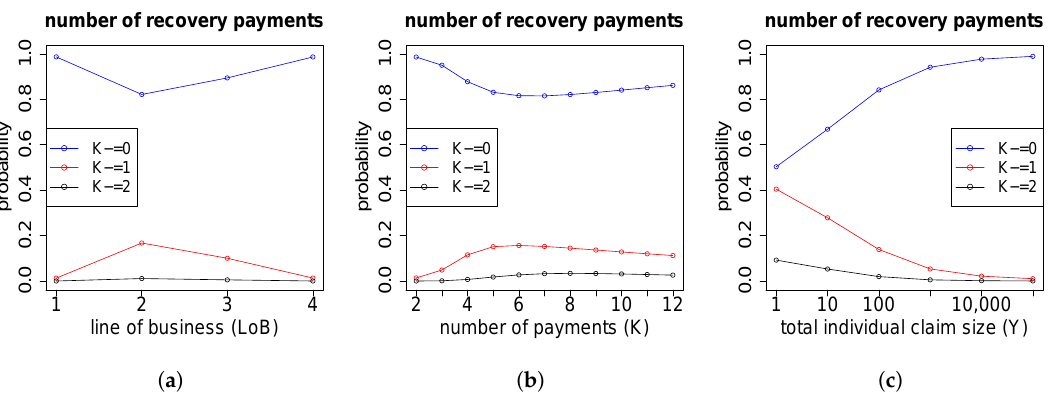
Figure A10. Number of recovery payments K − w.r.t. the features ( a ) LoB ; ( b ) number of payments K and ( c ) total individual claim size Y .